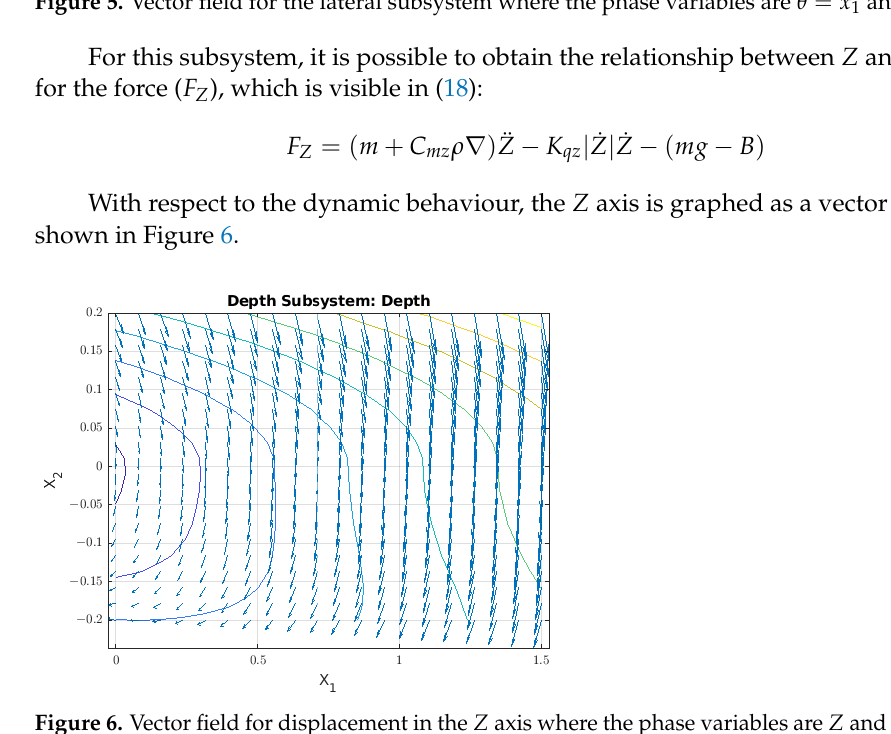
Figure 5. Vector field for the lateral subsystem where the phase variables are θ = x 1 and ˙ θ = x 2 .